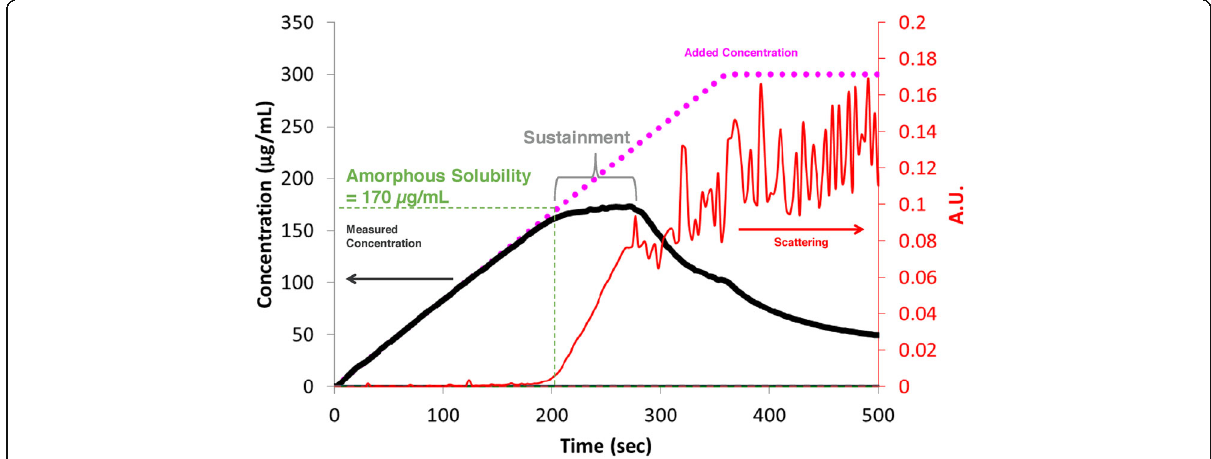
Fig. 8 Determining the impact of formulation on the “ parachute ” effect (reproduced with permission from